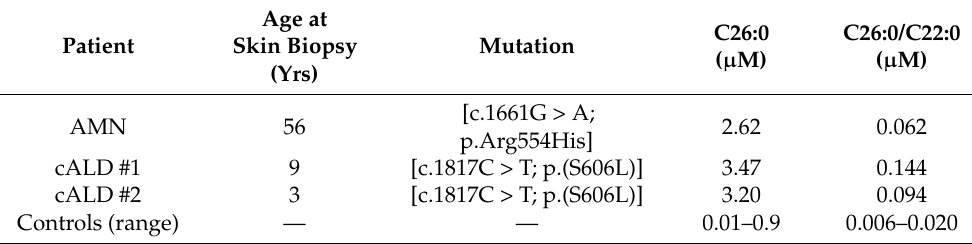
Table 1. Patients’